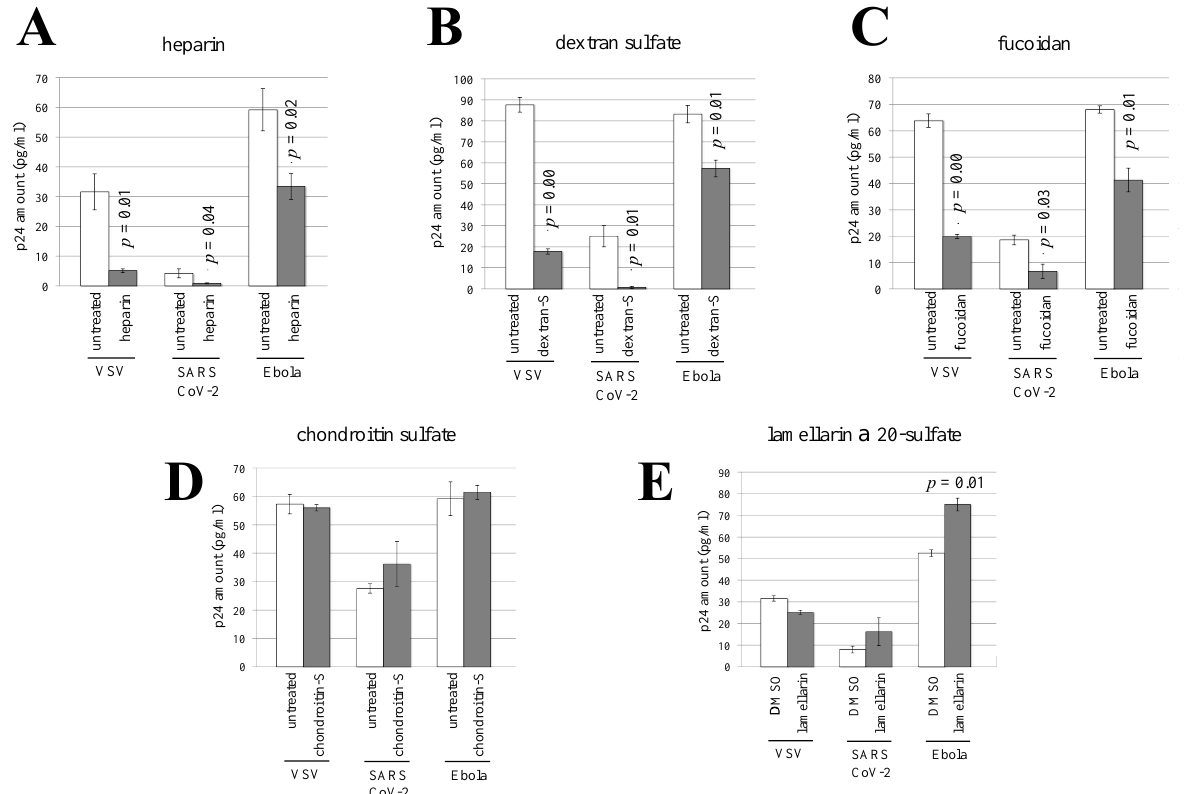
Figure 5. Effects of lamellarin α 20-sulfate and sulfated polysaccharides on the interaction between HIV-1 vector particles and target cells. Human 293T cells were incubated with the indicated pseudotyped vector at 4 °C for 2 h in the presence of heparin (50 µg/mL) ( A ), dextran sulfate (50 µg/mL) ( B ), fucoidan (50 µg/mL) ( C ), chondroitin sulfate (50 µg/mL) ( D ), and lamellarin 20-sulfate (150 µM) ( E ). The cells were vigorously washed with PBS, and cell lysates were prepared. The amounts of HIV-1 p24 protein in the cell lysates were measured by ELISA. This experiment was performed in triplicate. Error bars indicate SD. When the differences compared to the control cells are significant, the p values of Student ’s t -test are indicated.